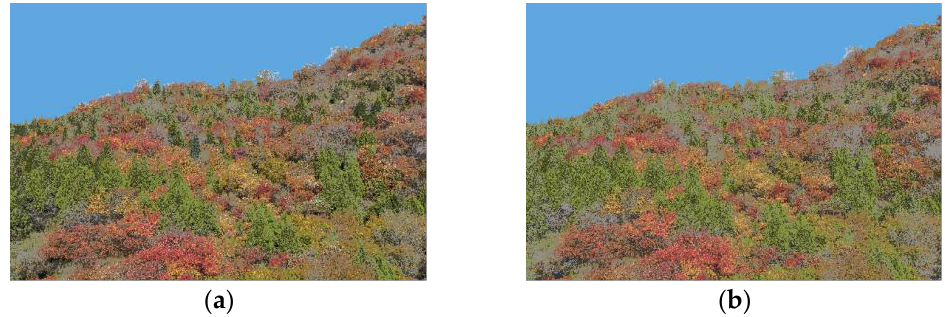
Figure A3. The sample photograph with 256 colors and 25 colors. ( a ) The photograph with 256 colors; ( b ) the photograph with 25 colors.